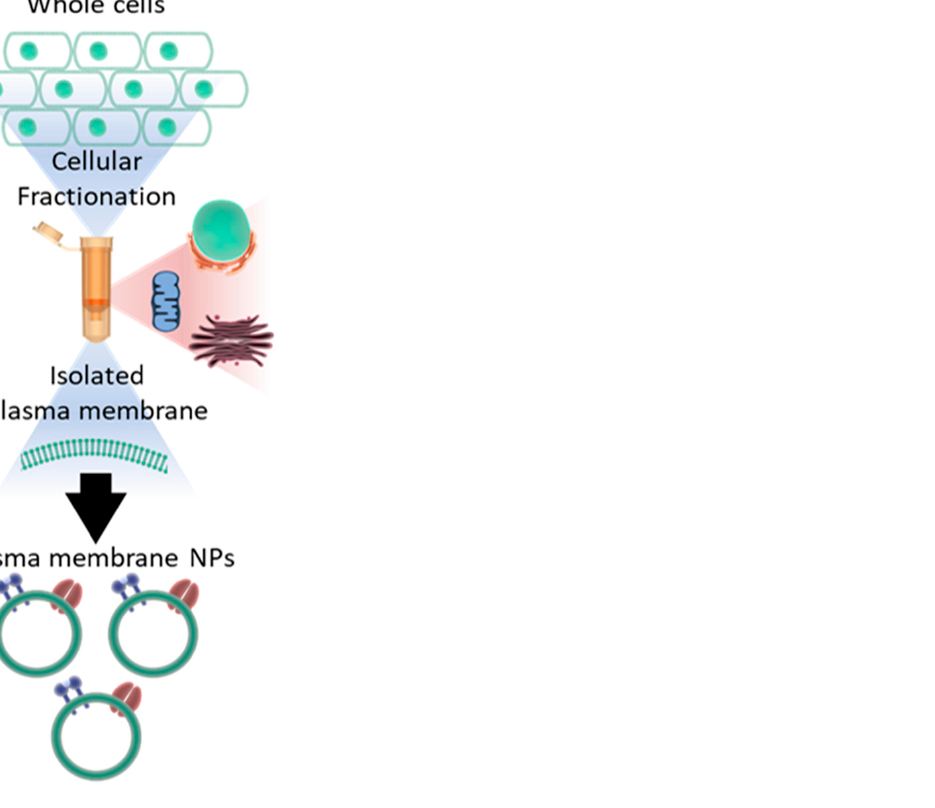
Figure 1. Schematic representation of how the whole cells were fractionated into plasma membrane NPs.